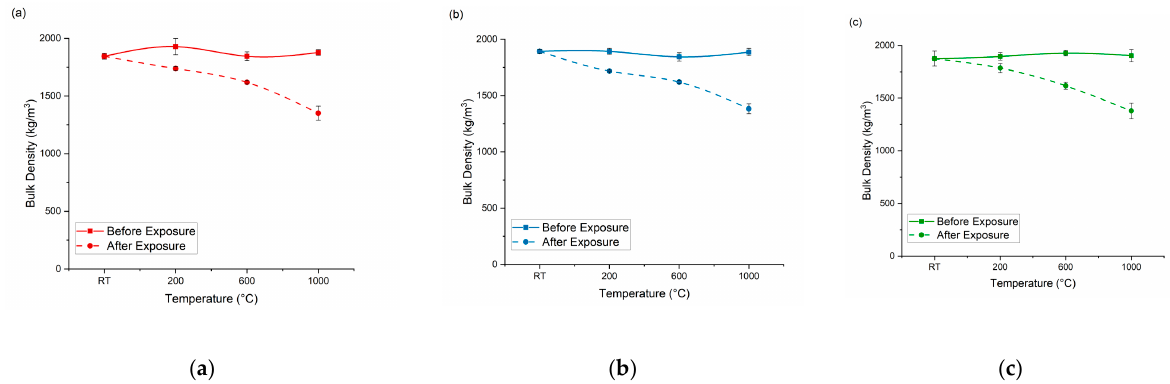
Figure 4. Density of fly ash geopolymers with ( a ) 0%, ( b ) 2%, and ( c ) 4% of silica fume before and after exposure to elevated temperature.